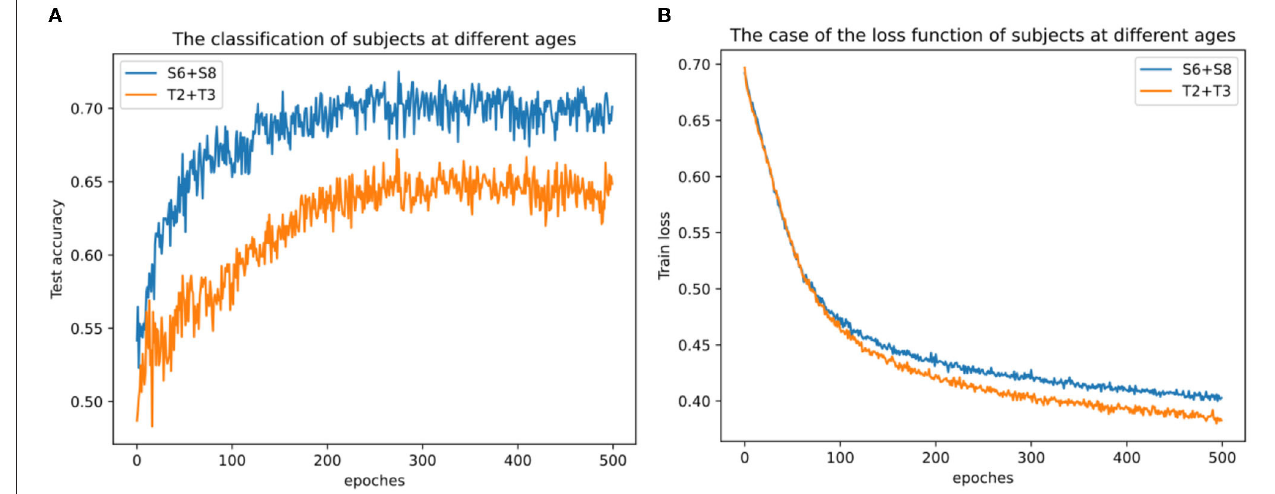
FIGURE 12 | Classification results across subjects with mixed datasets. (A) Classification results across subjects with mixed datasets at different ages and (B) loss function across subjects with mixed datasets at different